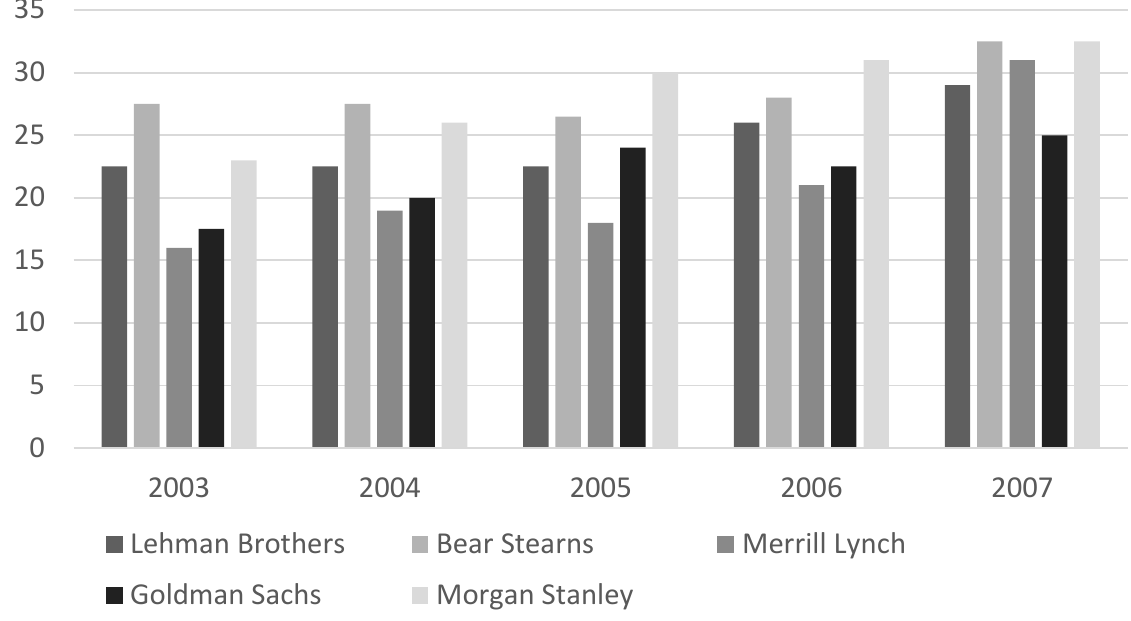
Figure 1. The leverage ratio of major investment banks from 2003 to 2007 (Winston Chang, 2011